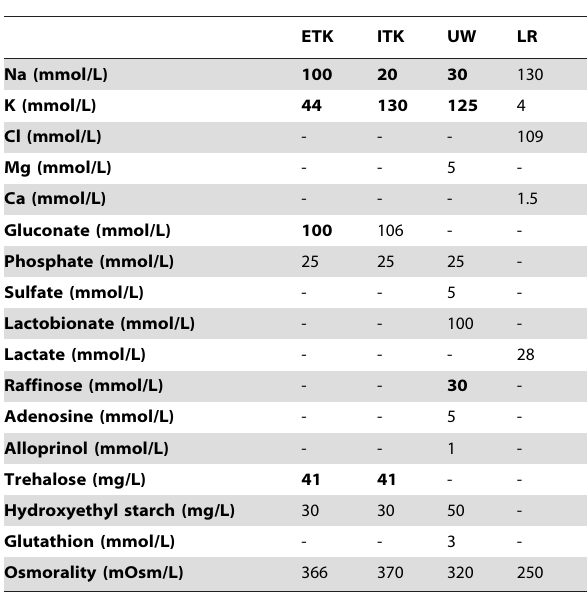
0.19 mg/mL, while the detection time was 1 s. The measurement Table 2. Compositions of ETK, ITK, UW or